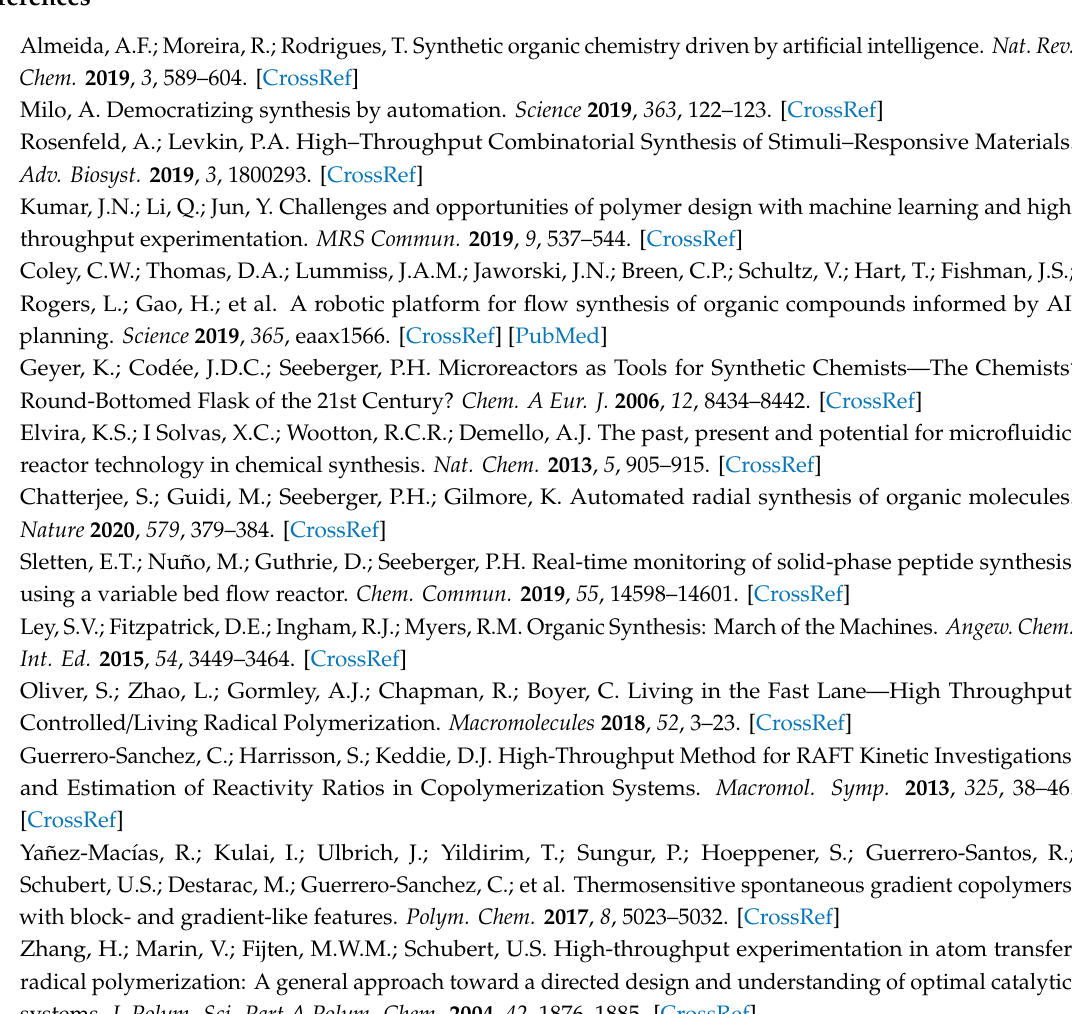
Figure S1: NMR kinetic (CDCl3) of the manual dialysis M2 (green 0 h, blue 3 h, red 9 h, black 24 h), Figure S2: NMR kinetic (CDCl3) of the manual dialysis M3 (green 0 h, blue 3 h, red 9 h, black 24 h), Figure S3: NMR kinetic (CDCl3) of the automated dialysis A2 (modus 1) (green 0 h, blue 3 h, red 9 h, black 24 h), Figure S4: NMR kinetic (CDCl3) of the automated dialysis A3 (modus 1) (green 0 h, blue 3 h, red 9 h, black 24 h), Figure S5: NMR kinetic (CDCl3) of the automated dialysis A4 (modus 2) (green 0 h, blue 3 h, red 9 h, black 24 h), Figure S6: SEC curve of the polymer P1 (blue), P2 (red) and P3 (black) (solvent: chloroform / isopropanol / triethyl-amine [94 / 2 / 4]), Table S1: Details of the utilized standards for SEC-calibration. The listed molar masses (Mn) are molar mass at the peak maximum. The supplier of the standards is PSS GmbH, Figure S7: Schematic representation of the technical details of the dialysis apparatus, Figure S8: Automated dialysis equipment without pump (a: picture of the complete device; b: zoom in the injection port; c: zoom in the dialysis tube), Figure S9: Overview of the manual dialysis using Sudan I as dye for the visualization. The solvent was changed every 12 h (400 mL each), Figure S10: Overview of the automated dialysis using Sudan I as dye for the visualization. The solvent was changed continuously (35 mL / h). Video